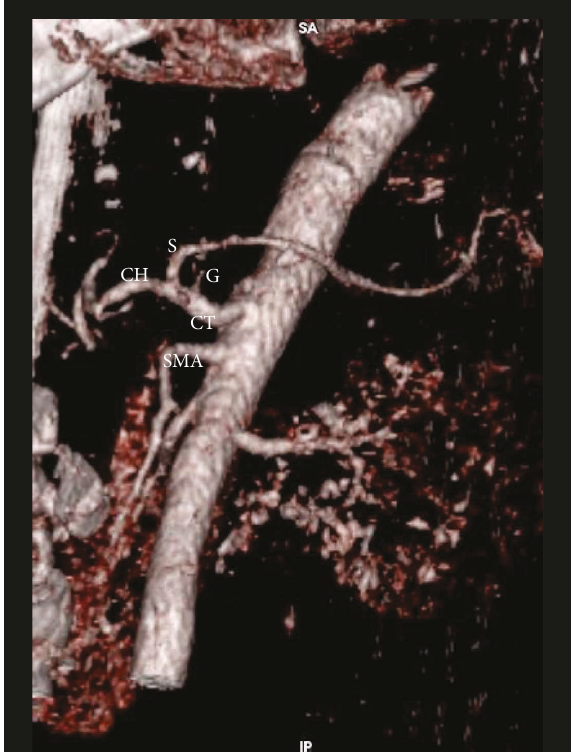
Figure 1: Three-dimensional volume rendering CT image shows normal branching patterns from the abdominal aorta. The celiac trunk (CT) is the most cephalad branch and gives off three branches: the splenic (S), left gastric (G), and common hepatic (CH) arteries. The superior mesenteric artery (SMA) arises at the L1 vertebral level from the